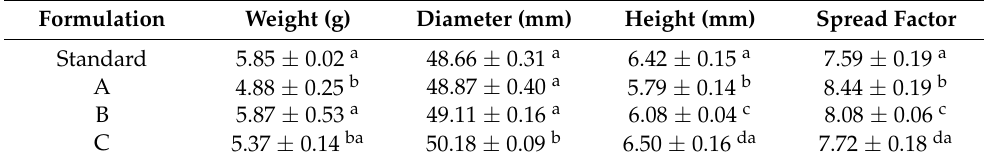
Table 5. Physical properties of the cookies after baking for standard formulation, formulation A (1% biosurfactant), formulation B (0.5% biosurfactant) and formulation C (0.25% biosurfactant).